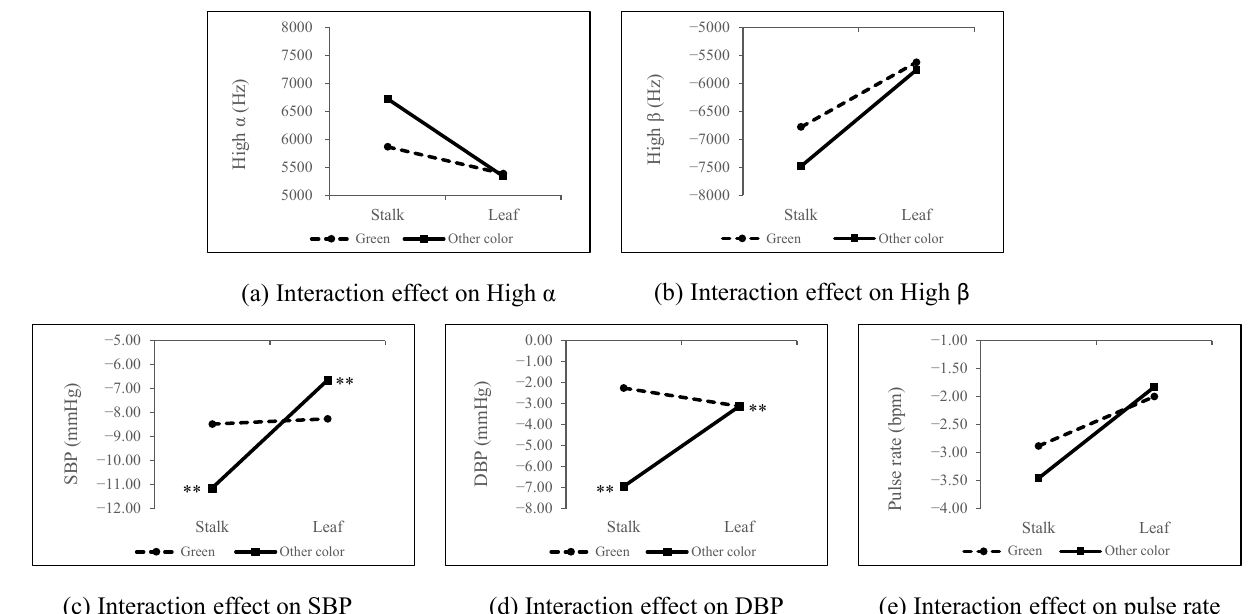
Figure 8. Interaction effect of organ and color on physiological indicators. SBP: systolic blood pressure; DBP: diastolic blood pressure, n = 300; mean ± SE, ** p < 0.01.